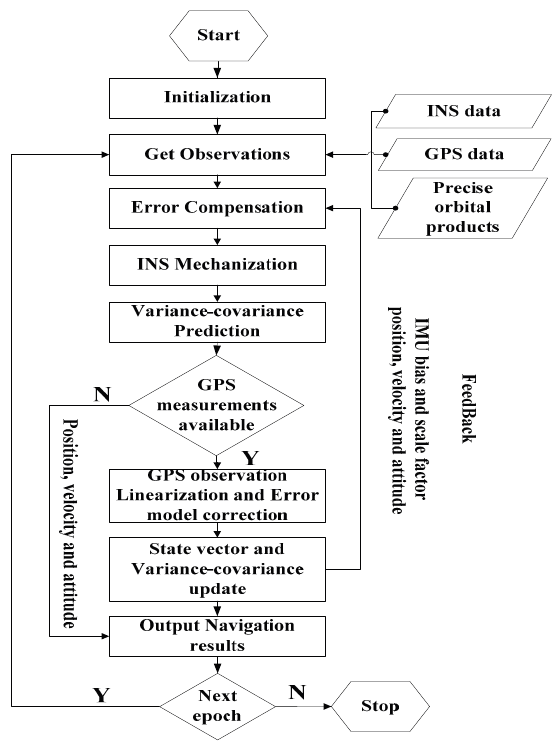
Figure 1. IC-PPP/INS tightly coupled integration